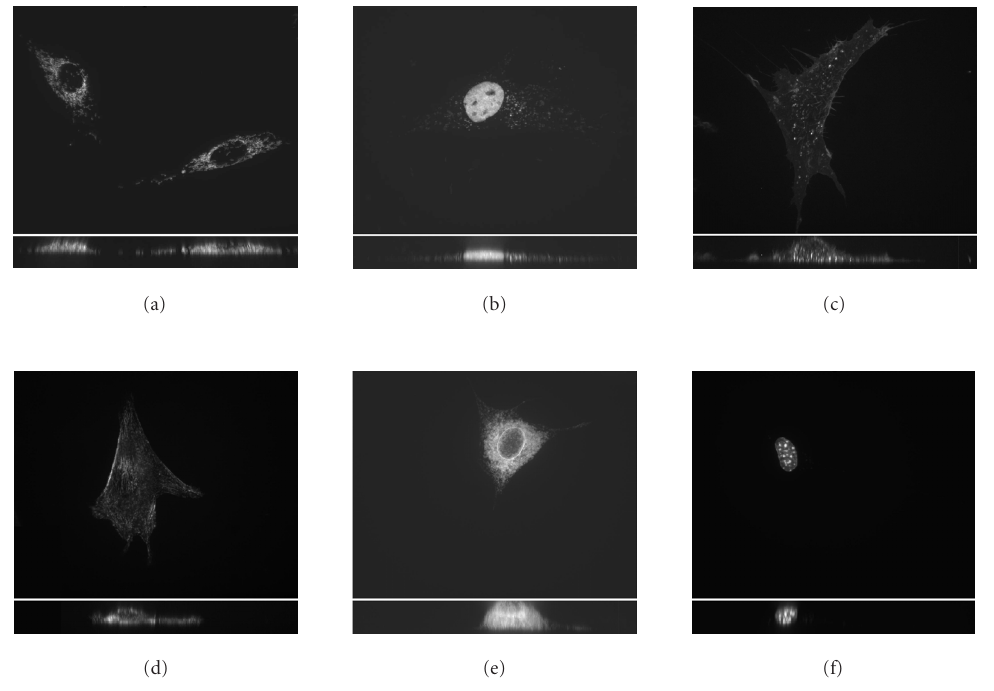
Figure 2. Selected images from the 3D 3T3 image dataset. Tagged protein names are shown with a hyphen followed by a clone number if the same protein was tagged in more than one clone in the dataset. Representative images are shown for (a) Atp5a1-1, (b) Ewsh, (c) Glut1, (d) Tubb2-1, (e) Canx, and (f) Hmga1-1. The top portion of each panel shows a projection on the x - y plane and the bottom shows a projection on the x - z